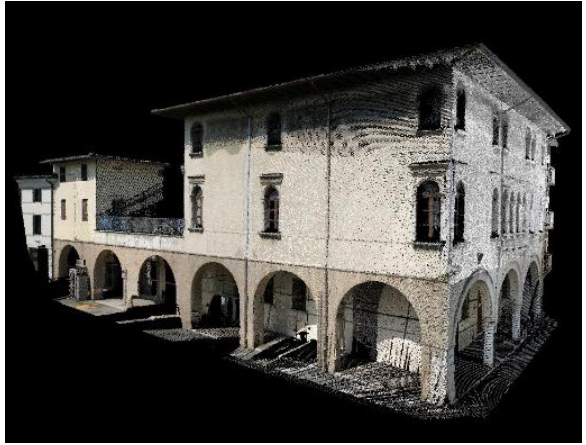
Figure 1. Acquired TLS points